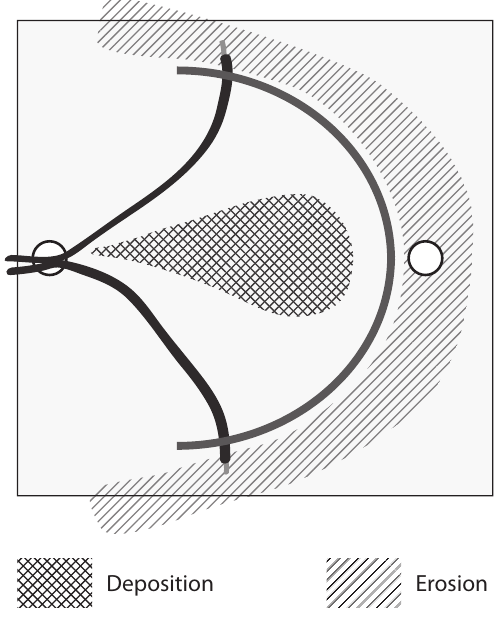
Fig.2. Schematicoftypicalerosionalanddepositionalareasaround the sensor head under lab conditions. Fig. 2. Schematic of typical erosional and depositional areas around the sensor head under lab